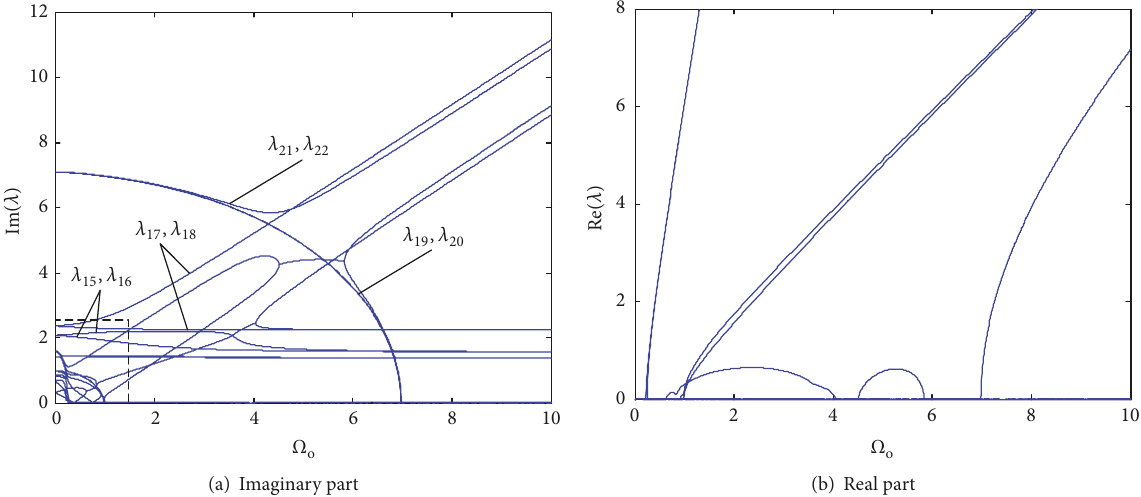
Figure 5: Imaginary and real parts of the eigenvalue for translational modes.